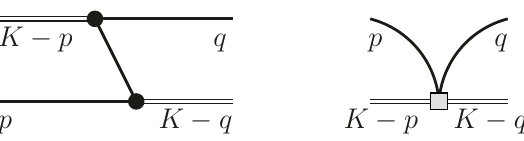
Figure 2 . The kernel of the Faddeev equation. Double and single lines denote the dimers and particles, respectively. The dark blob describes a dimer-two-particle vertex, and a shaded box corresponds to the short-range part of the particle-dimer